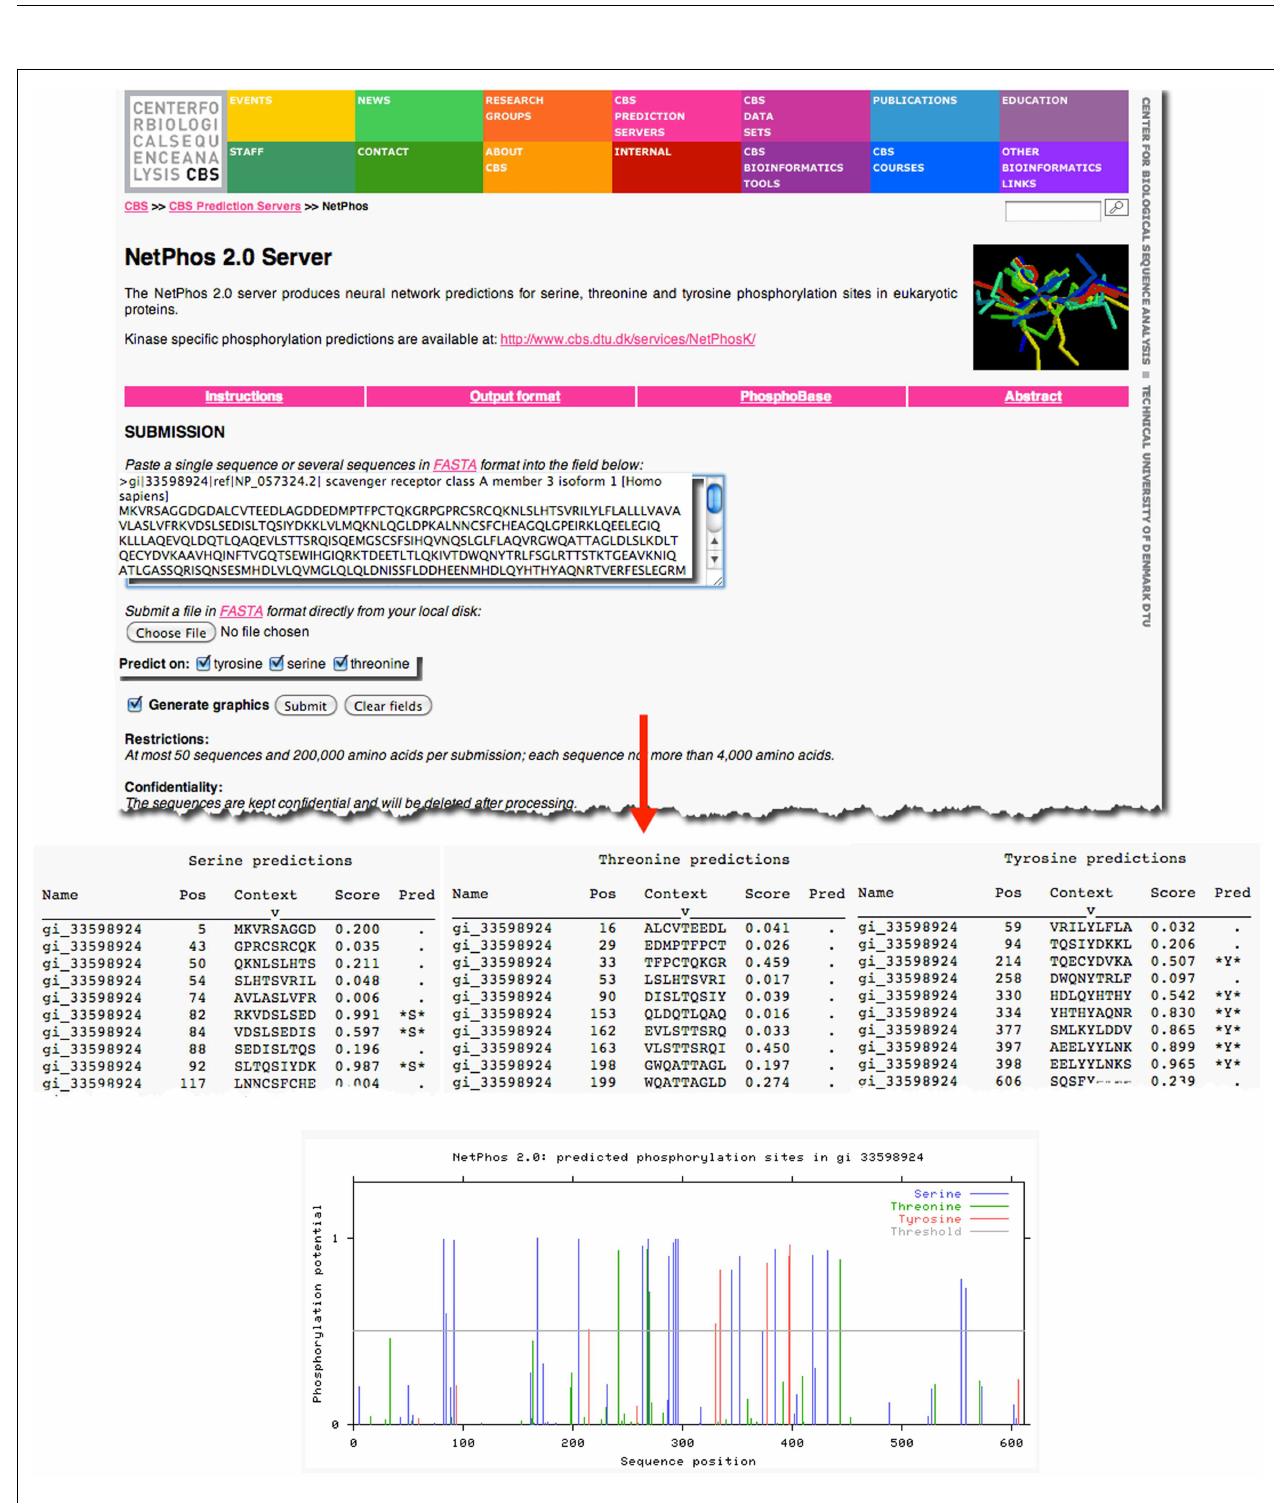
above 0.5 are considered to be significant and those residues are highlighted in the “ Pred ” column with asterisks.The Server also displays the output graphically, including a horizontal line to indicate the 0.5 score threshold. Multiple residues in SCARA3 reach this threshold of significance, and may guide further in vitro analysis of this